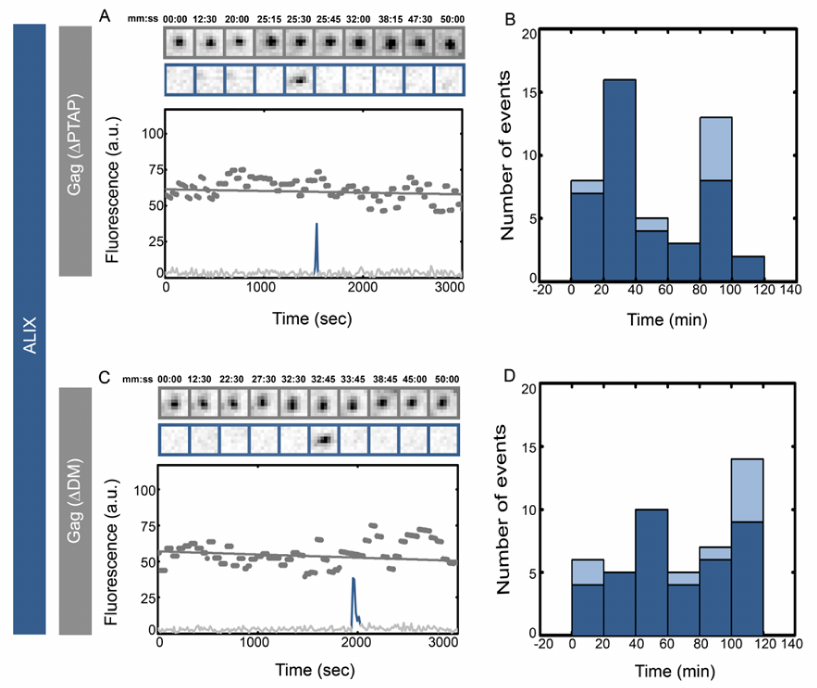
Figure 5. Delayed transient recruitment of ALIX into HIV Gag (YP − + PTAP − ) VLPs or HIV Gag (PTAP − ) VLPs. HeLa cells stably expressing ALIX–h30–eGFP were transfected with 1500 ng of Gag (PTAP − )–mCherry ( A , B ) or Gag (PTAP − + YP − )–mCherry ( C , D ) and imaged 5 h after transfection. Intensity plots (as gray dots and fitted with gray line) of individual fully assembled representative VLPs are shown and cropped TIRF images of the Gag (top, gray) and AIX (bottom, blue) for ( A ) Gag(PTAP − )–mCherry VLPs and ( C ) Gag (PTAP − + YP − )–mCherry VLPs. Histograms of the first time (dark blue) and later recruitments (light blue) of ALIX are shown for ( B ) Gag (PTAP − )–mCherry VLPs and ( C ) Gag (PTAP − + YP − )–mCherry VLPs. Alix was recruited within 2 h after the start of the actual